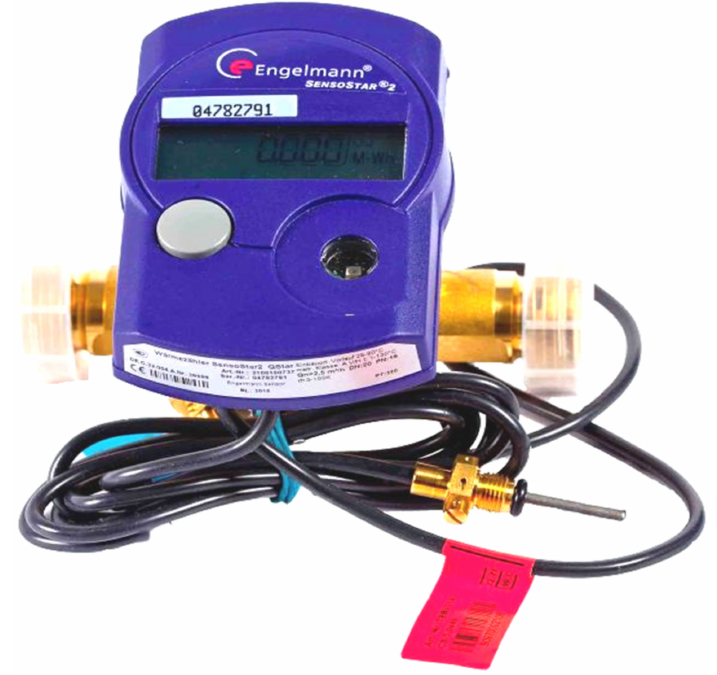
Figure 2. Engelmann Sensostar2 compact heat meters